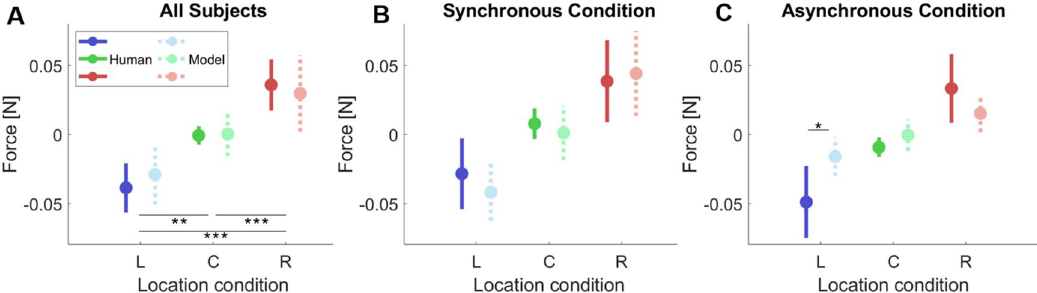
Figure 5. Comparison between the model predictions and human behavior ( A ) Mean force comparison between the human participants and the simulated ones with the active inference model for Left, Center and Right conditions. The continuous line corresponds to the human data and the dashed line with a lighter color to the model predictions. ( B ) Force comparison for the synchronous condition. ( C ) Force comparison for the asynchronous